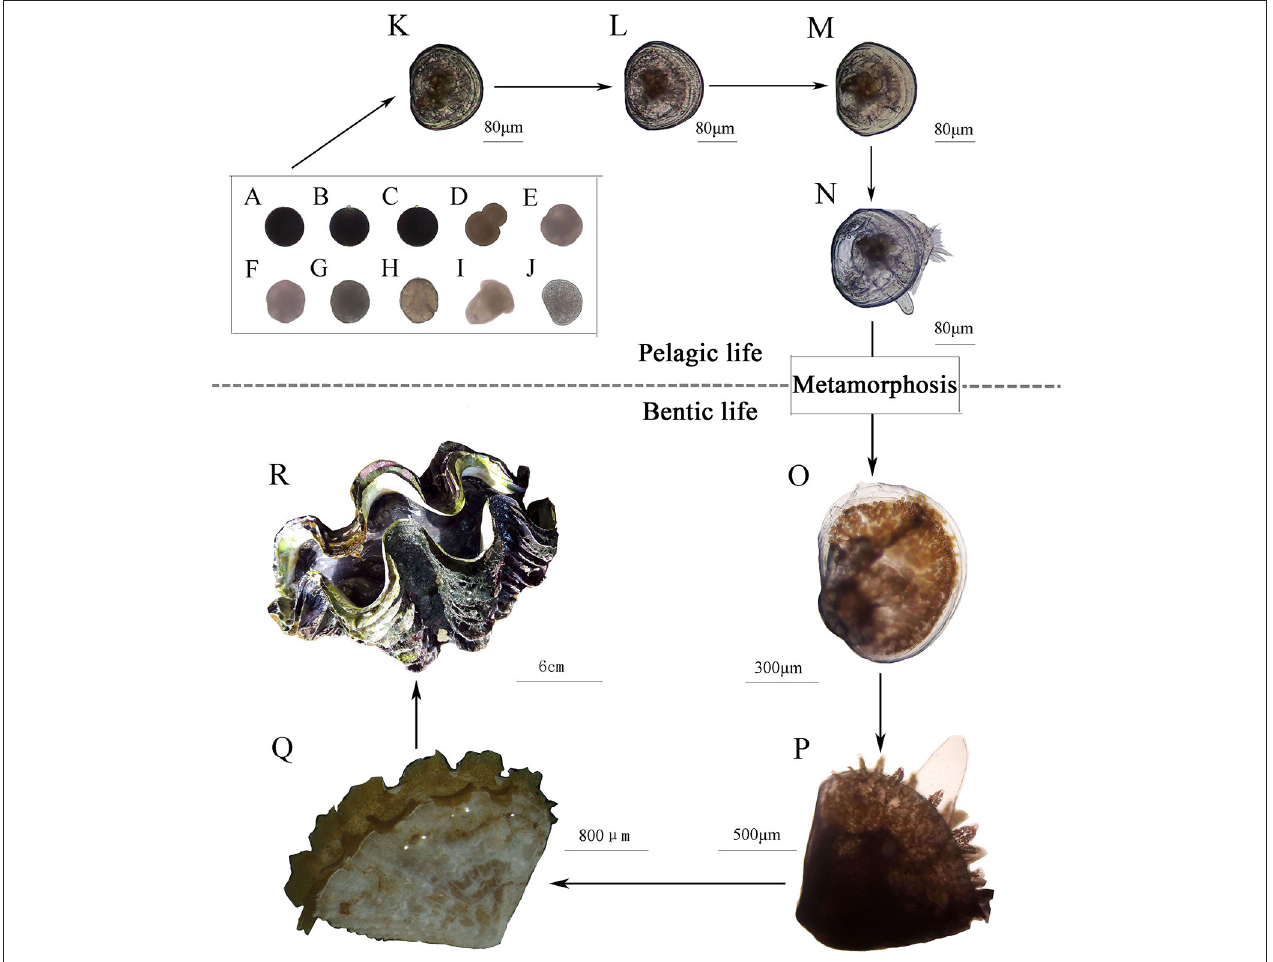
FIGURE 1 | Life cycle of giant clams ( T. squamosa ). (A) Fertilized egg; (B) First polar body; (C) Second polar body; (D) Two cells; (E) Four cells; (F) Eight cells; (G) Mulberry; (H) Blastocyst; (I) Trochophore; (J) D larva; (K) Early umbo-larva; (L) Middle umbo-larva; (M) Late umbo-larva; (N) Pediveliger; (O) Newly-formed spat; (P) Spat; (Q) Youth; (R)